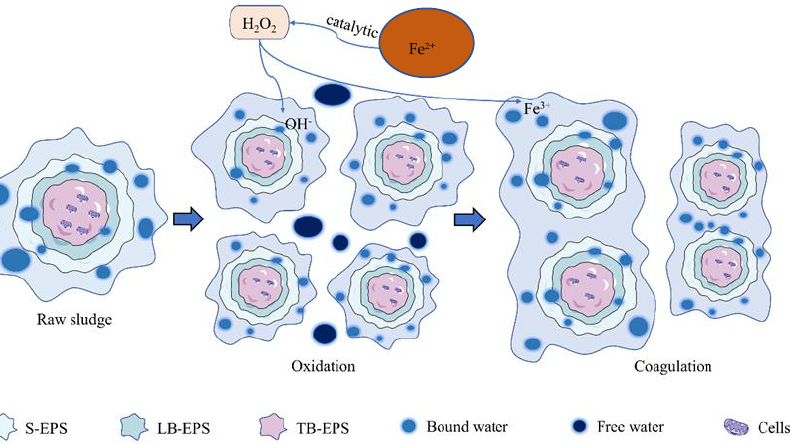
Figure 6. Two-step conditioning mechanism of oxidation and coagulation in Fenton reagent-conditioned sludge.